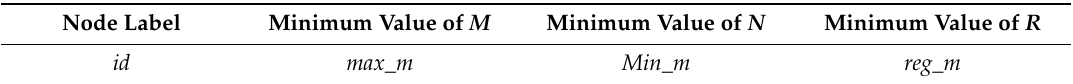
Table 2. The format of filter _